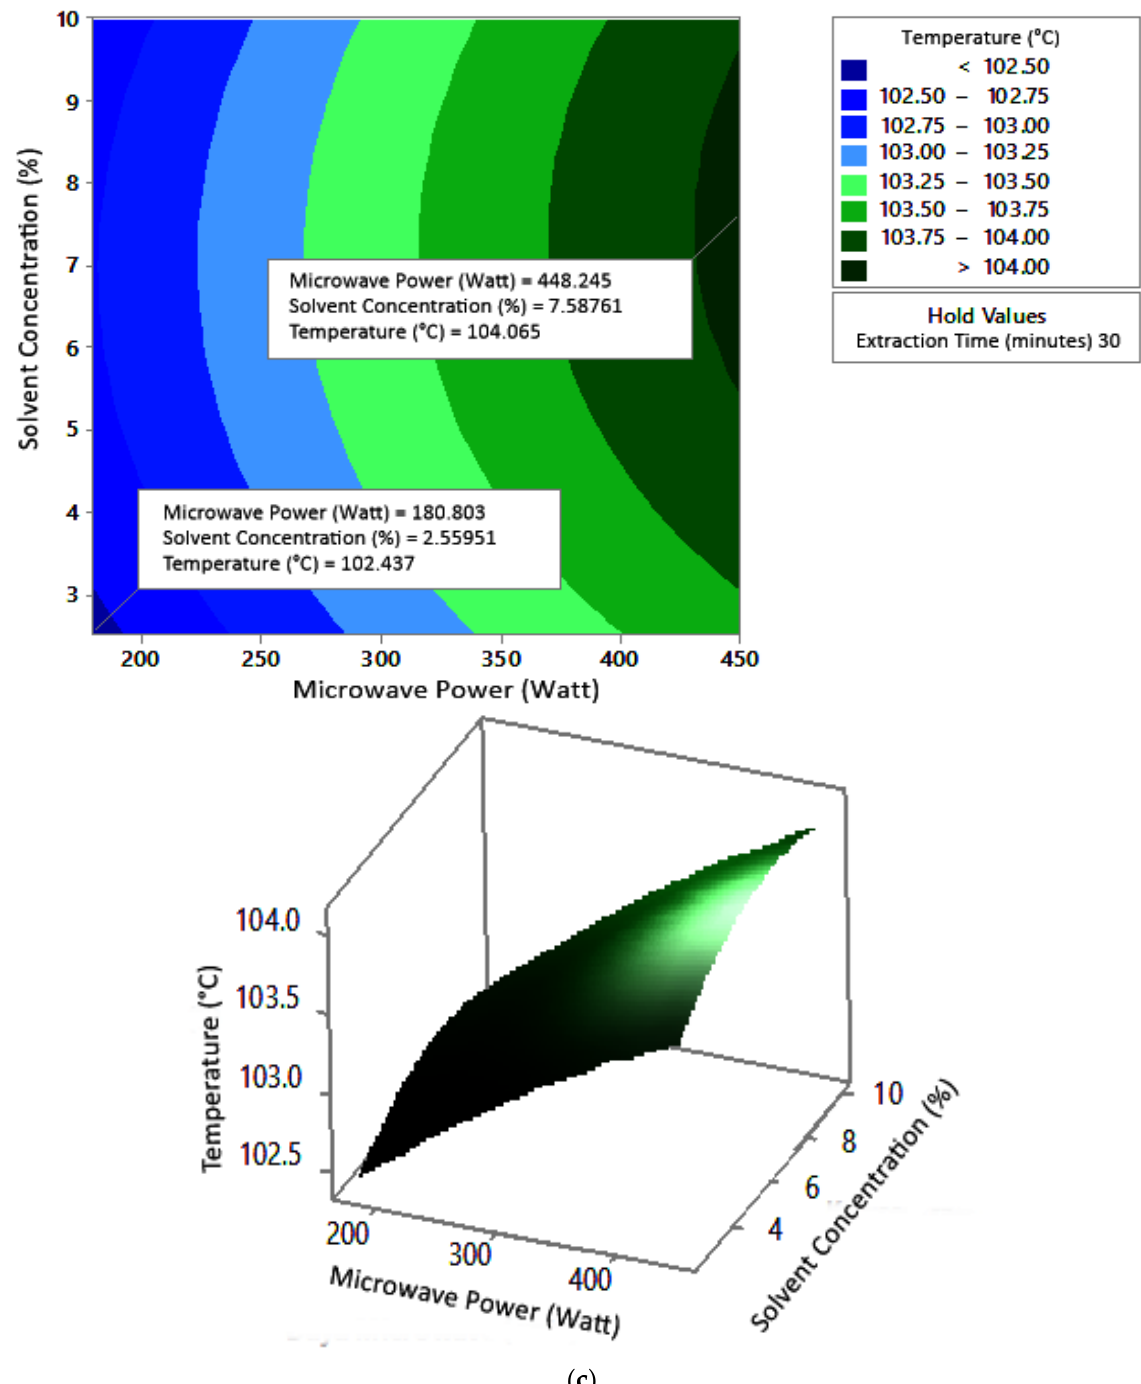
Figure 7. Effect of microwave power and solvent concentration on temperature at extraction times of ( a ) 20 min, ( b ) 25 min, and ( c ) 30 min.